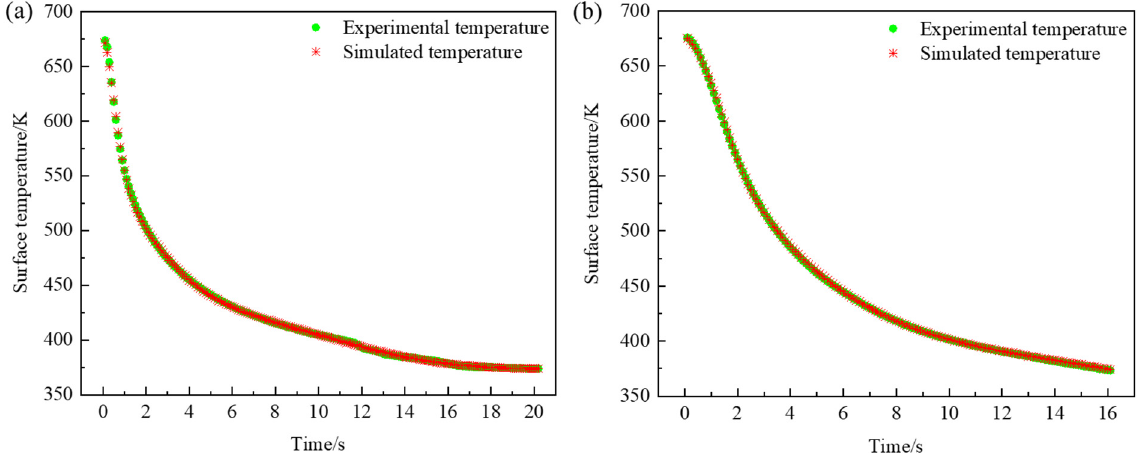
Figure 3. Comparison between simulated temperature and experimental temperature in impingement zone ( a ) and free − falling zone ( b ).